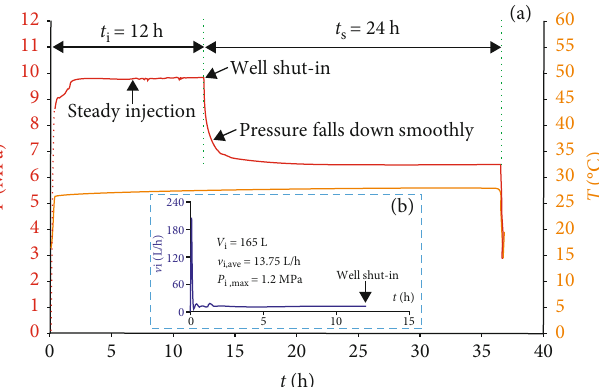
Figure 2: Injection/fallo ff curves of an actual CBM well: (a) relationship between pressure/temperature and time; (b) the relationship between the injection rate at the surface and time: V i represents the total injection volume, v i,ave represents the average injection rate at the surface, P represents the pressure, P i represents the maximum injection pressure at the surface, t represents the time, t i represents the injection time, t s represents the well shut-in time, and T represents the coal reservoir temperature.